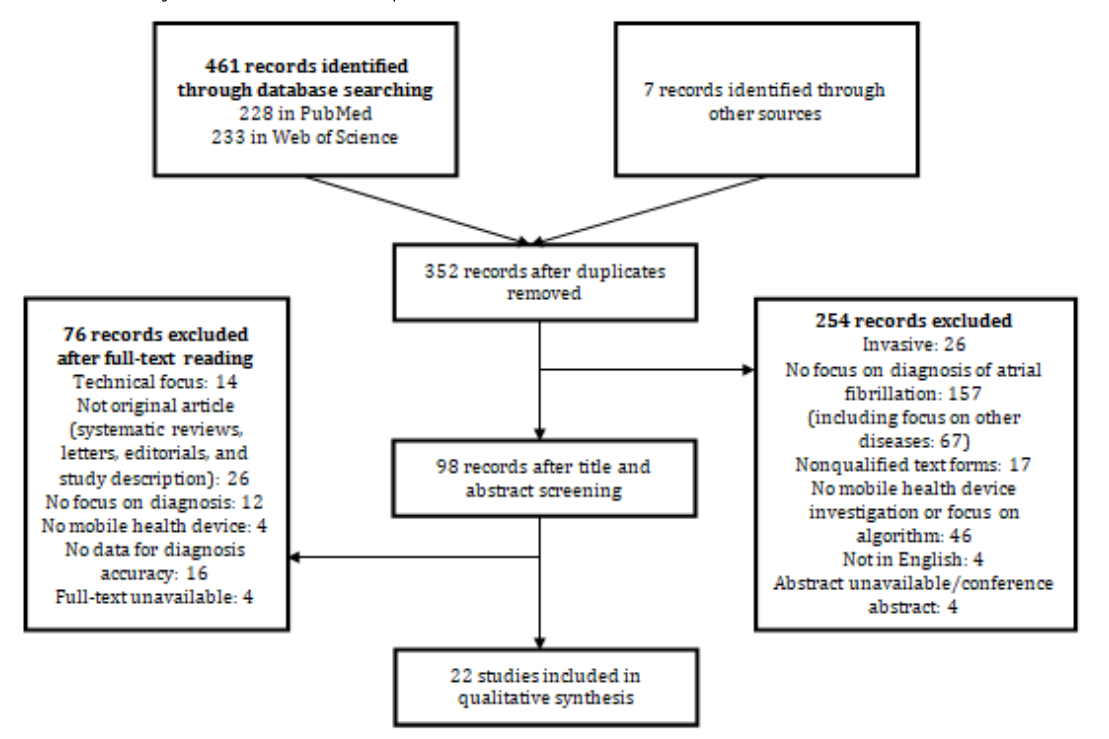
Figure 1. Flowchart of the systematic literature review